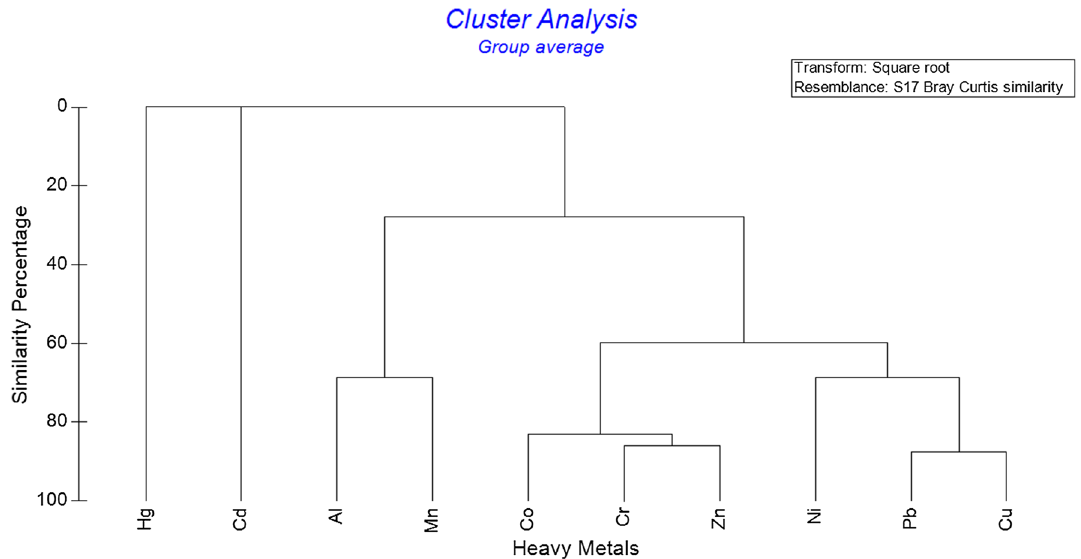
Fig. 4 Dendrogram showing the percentage of similarity among heavy metals during different seasons